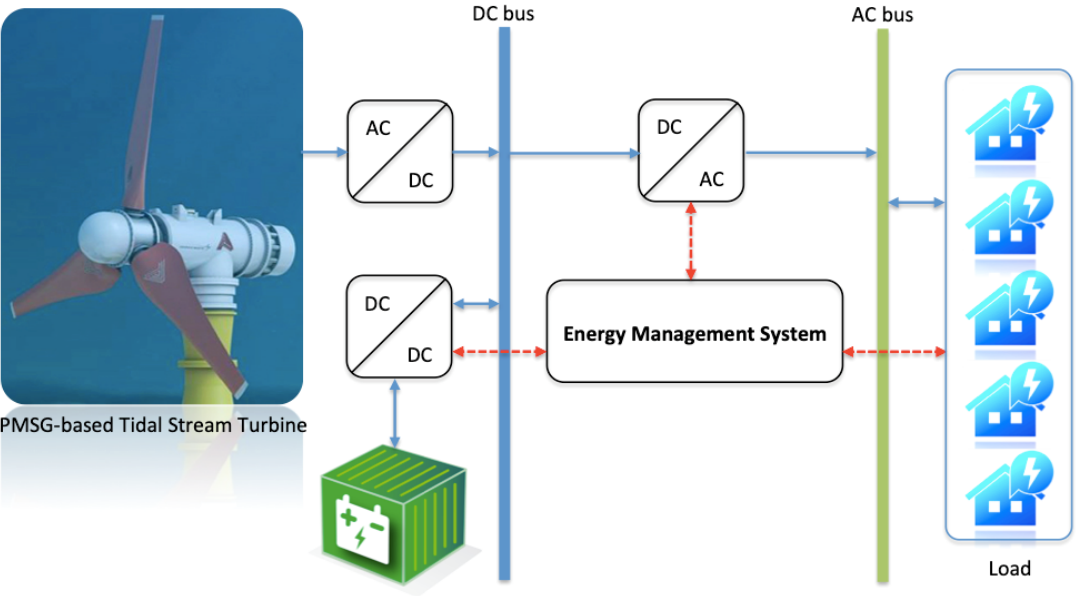
Figure 1. TST – battery system configuration. Figure 1. TST–battery system